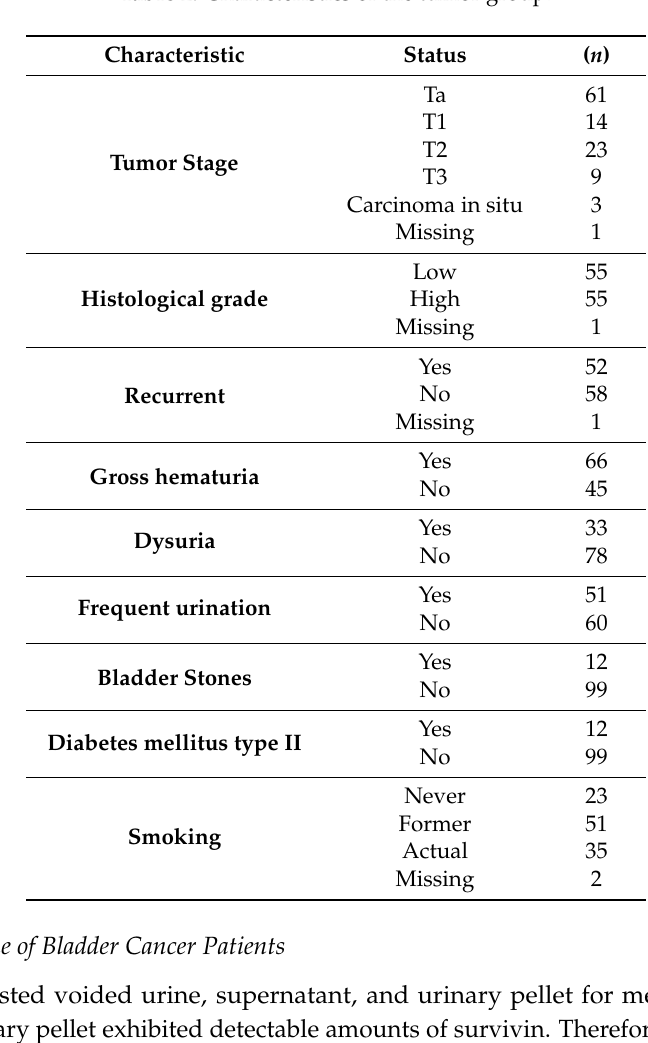
Table 2. Characteristics of the tumor group.